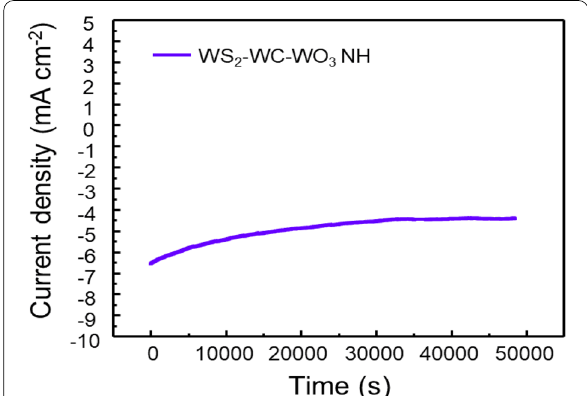
Fig. 6 Time-dependent current density of the WS 2 –WC–WO 3 NH spheres at 0.33 V for 50,000 −